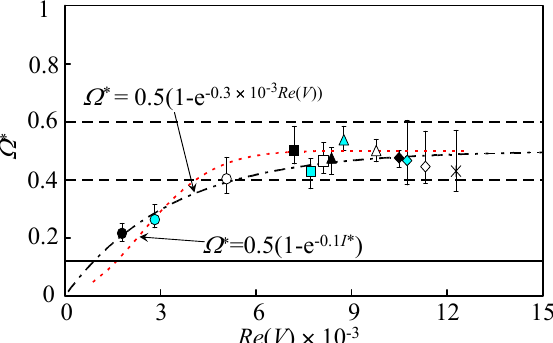
Fig. 16 Reduced rotating rate Ω * of a tumbling plate versus Reynolds number Re ( V ) based on a theoretical descent velocity V , for several values of inertia-moment ratio I * at depth-to-width ratio λ = 0.3, aspect ratio AR = 10, C = 3.86 × 10 2